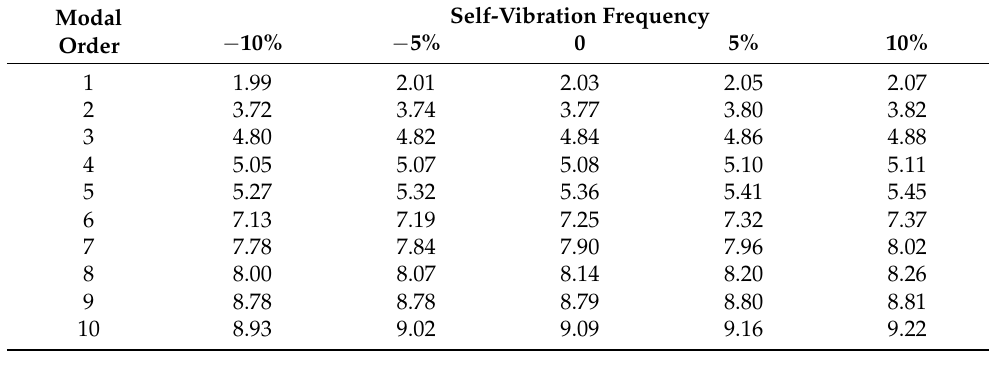
Table 9. Self-vibration frequencies (Hz) for different V-shaped pier stiffnesses of Structure II.